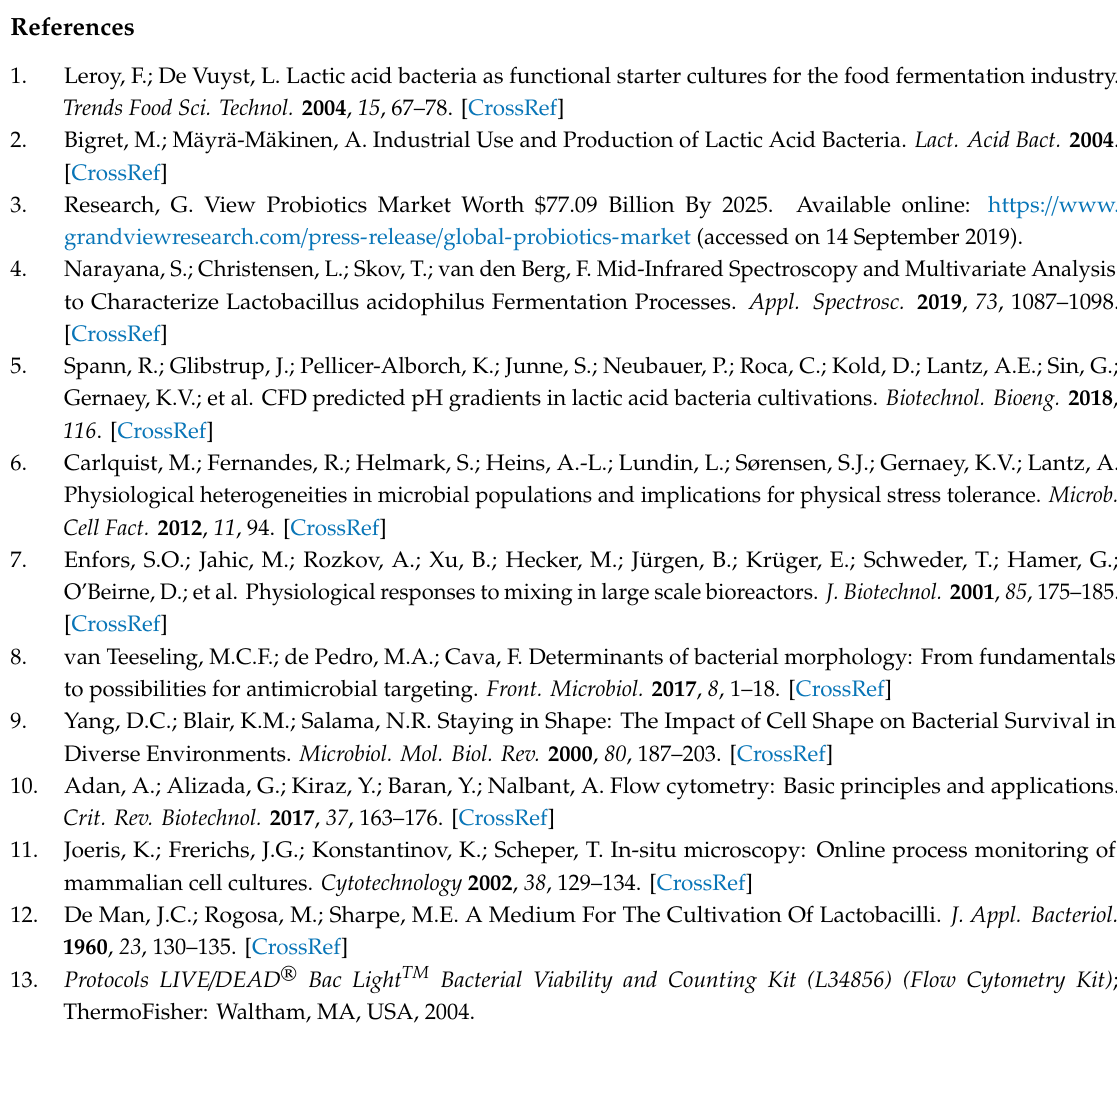
Figure A4. Plot of FL 1 against FL 2 fluorescence intensities of hourly samples showing dynamics of clusters observed during fermentation for pH-C (1) batch.